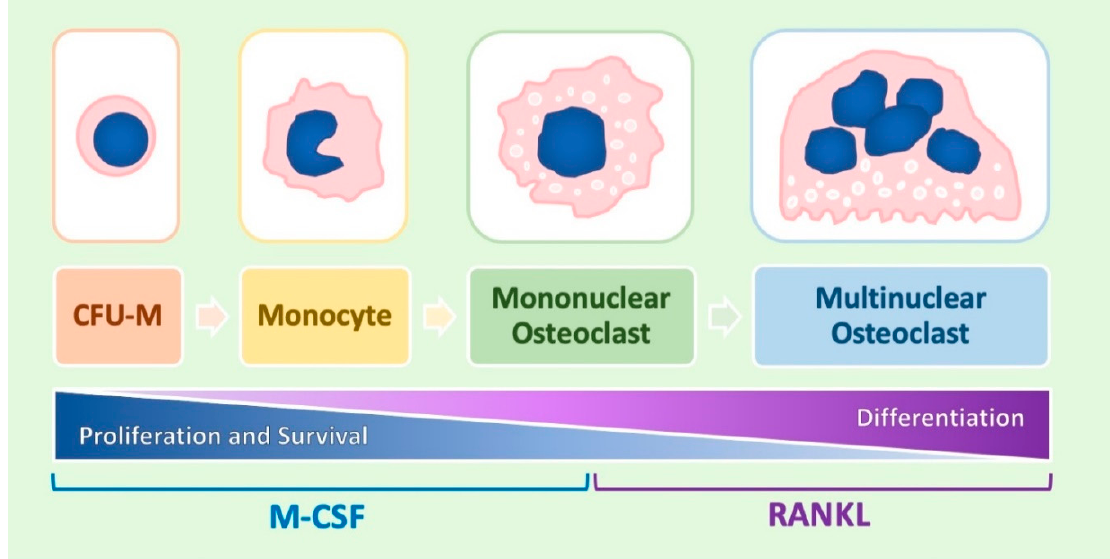
Figure 1. The different steps of osteoclast differentiation. Osteoclastogenesis consists of four main steps, represented in the figure from the left to the right: colony-forming unit monocyte (CFU-M), monocyte, mono-nuclear osteoclast, and multinuclear osteoclast. The initial phases of the process are supported by monocyte colony-stimulating factor (M-CSF), mainly exerting a proliferation/survival effect, whereas the remaining events are stimulated by ligand of receptor activating NF κ B (RANKL), promoting a terminal differentiation effect.